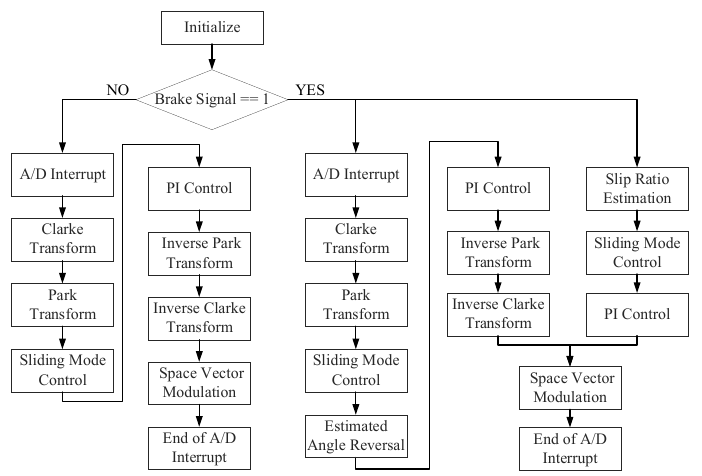
/ braking control